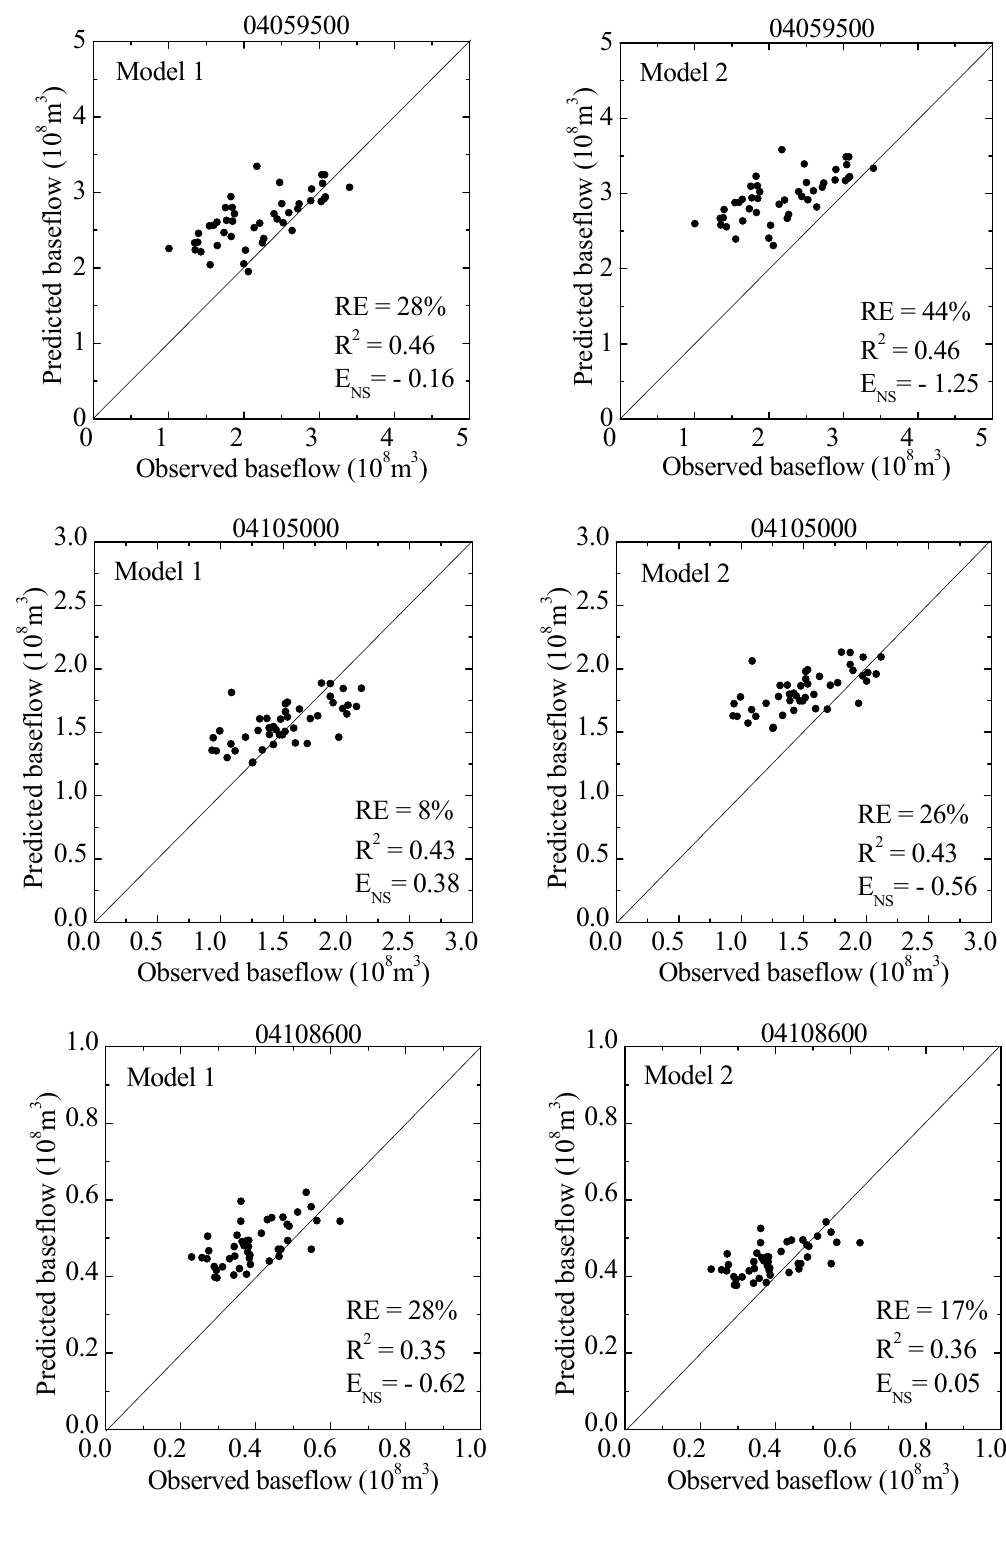
Figure 4. Predicted versus observed annual baseflow for Model 1 and Model 2 in watersheds used for model validation during 1967–2011